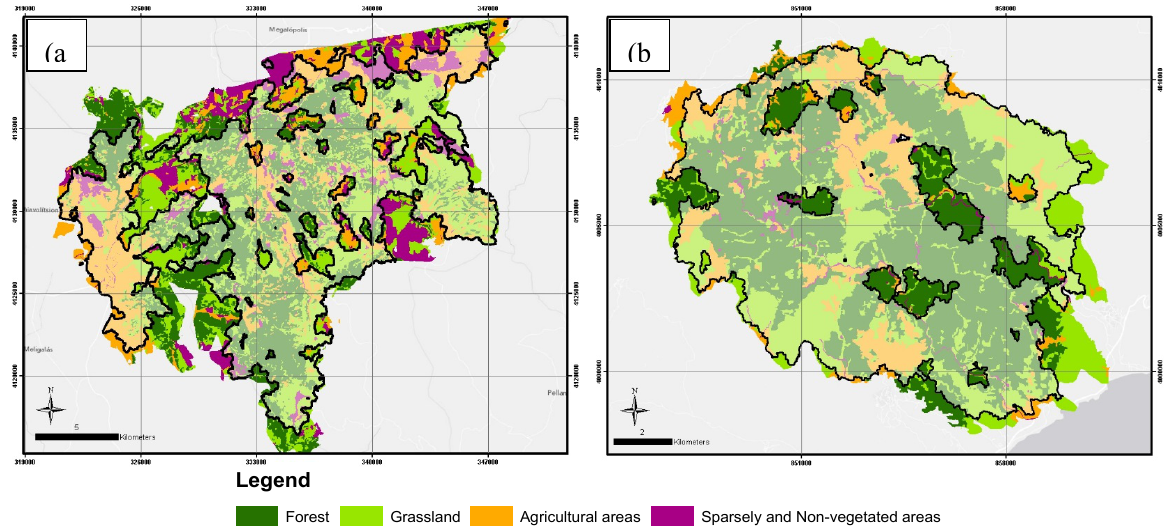
Figure 6. Black perimeters with the transparent white color show the burned area mapped by the object-based classification scheme and the multi-temporal Advanced Land Observing Satellite (ALOS) Phased Array type L-band Synthetic Aperture Radar (PALSAR) imagery in the Peloponnese ( a ) and in Rhodes Island ( b ). The perimeters are overlaid on the land-cover maps of the burned areas, which are generalized for viewing